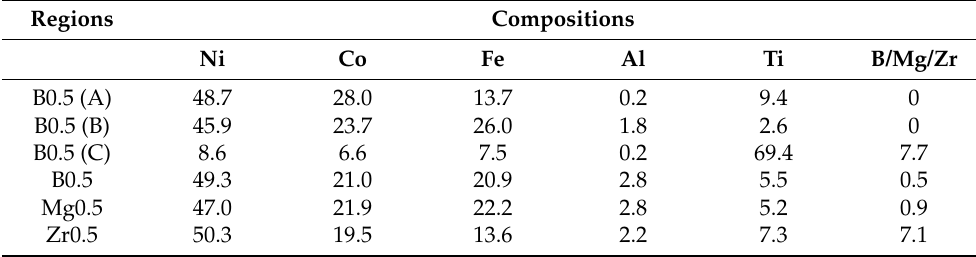
Table 1. Chemical composition of the three as-cast HEAs obtained by TEM-EDS (at. %). Regions Compositions